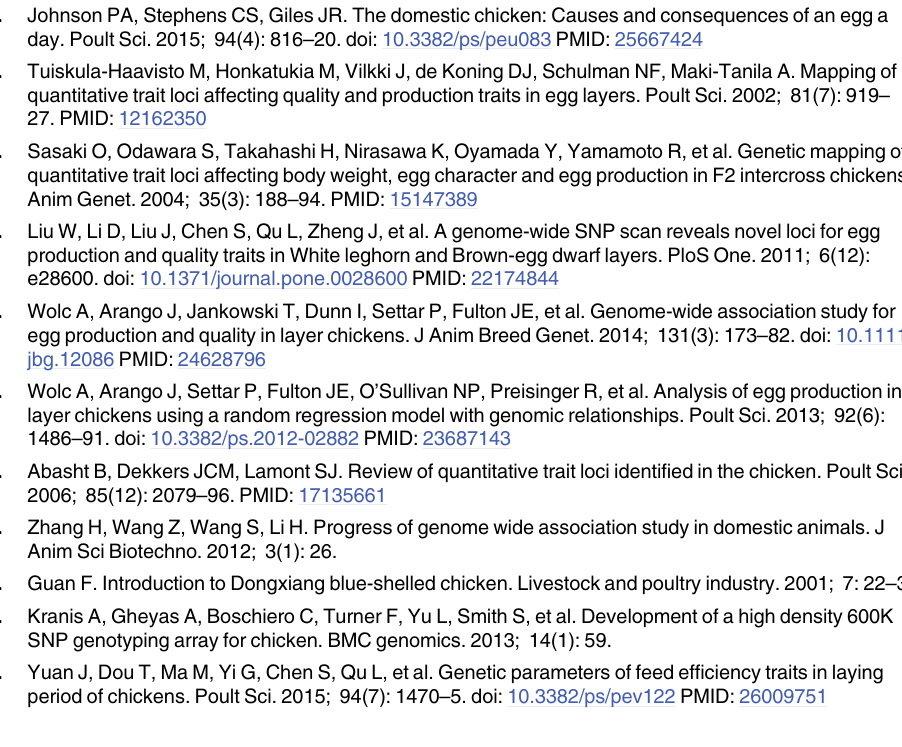
S6 Table. SNPs showing genome-wise significance of suggestive association ( P -value < 1.69e-5) with egg laying rate. 1 : Chicken chromosome. 2 : first listed marker is minor allele. 3 : minor allele frequency. 4 : allele substitution effect. 5 : U and D indicates that the SNP is upstream and downstream of the gene. (XLSX).